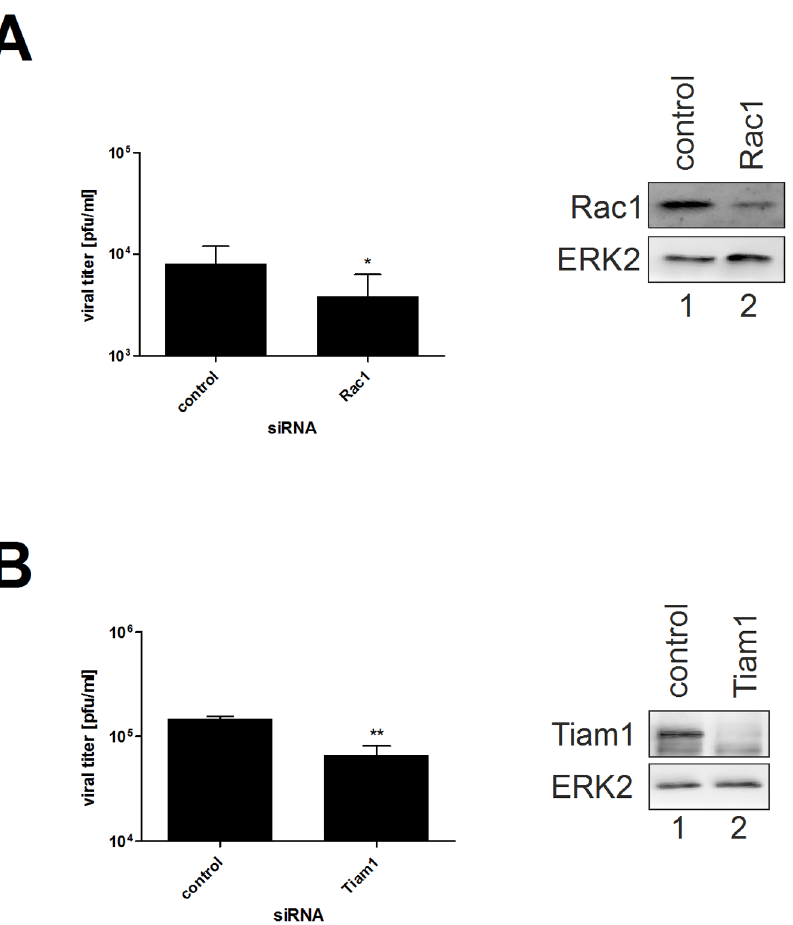
Figure 3. The siRNA mediated knockdown of Rac1 or Tiam1 leads to impaired viral replication. A549 cells were transfected with non- silencing control siRNA or siRNA against Rac1 (A) or Tiam1 (B) for 72 or 48 h, respectively. Thereafter, cells were infected with A/Puerto-Rico/8/34 rec. (moi=0.01) for 24 h. Progeny virus yields were determined by plaque assays. Data represent means 6 SD of three independent experiments including two biological samples. Statistical significance was evaluated by Student’s t -test (* p , 0.05; ** p , 0.01). Efficient knockdown of Rac1 or Tiam1 was determined in Western blot analysis using specific antibodies against Rac1 or Tiam1, respectively. Detection of ERK2 served as a loading control.